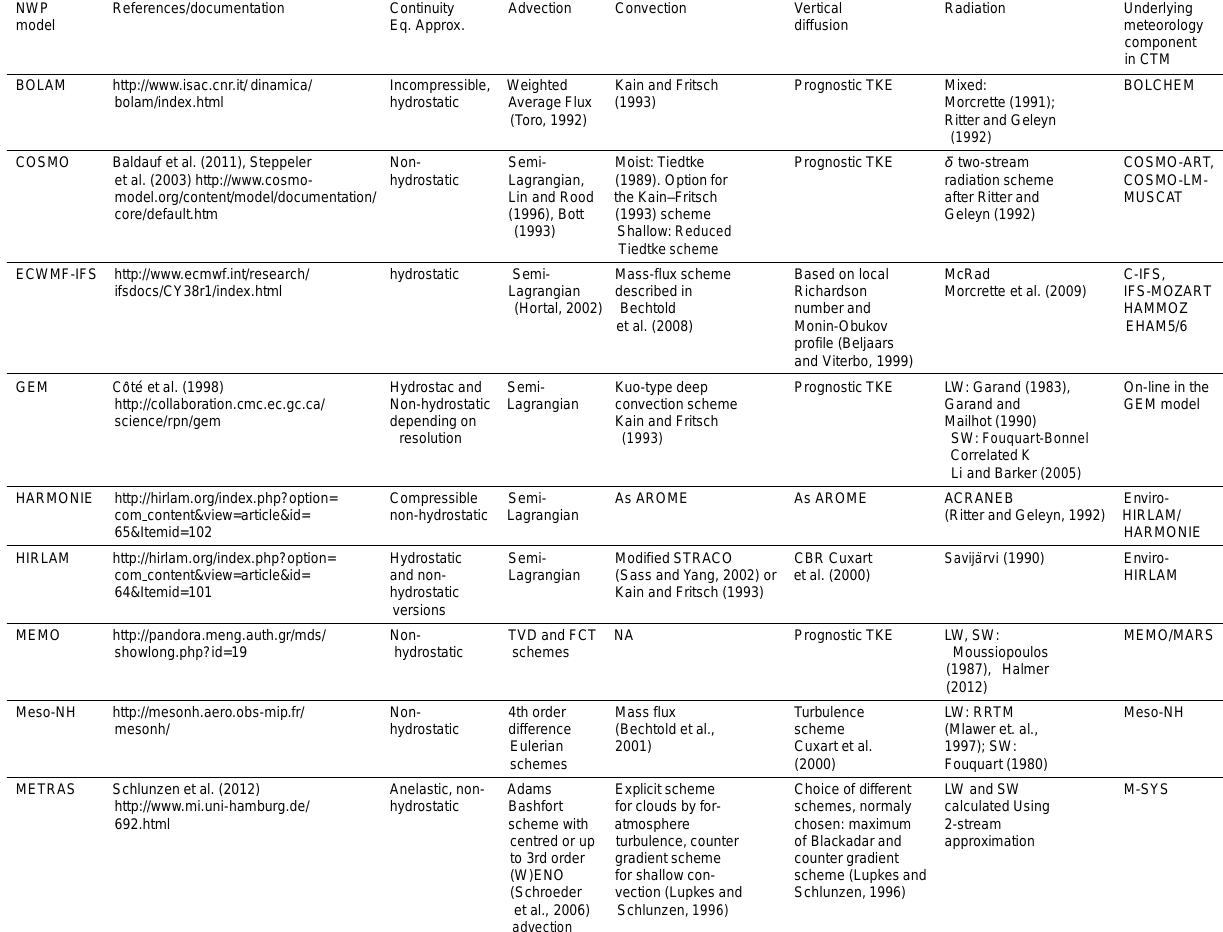
Table 5. Meteorology models currently used as basis for coupled models.